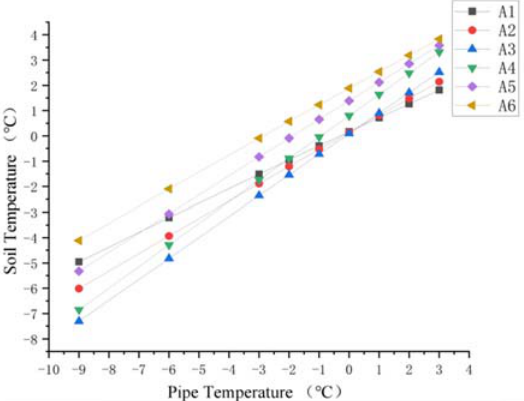
Figure 13. Diagram of soil temperature trend at point A1–A6.